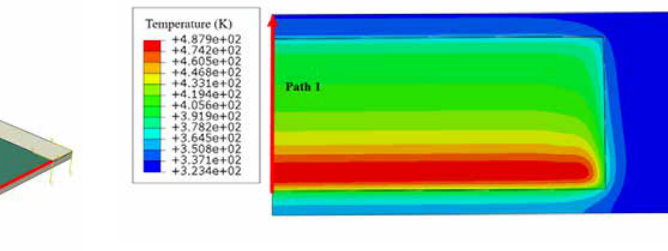
Figure 11: The contour plot of temperature